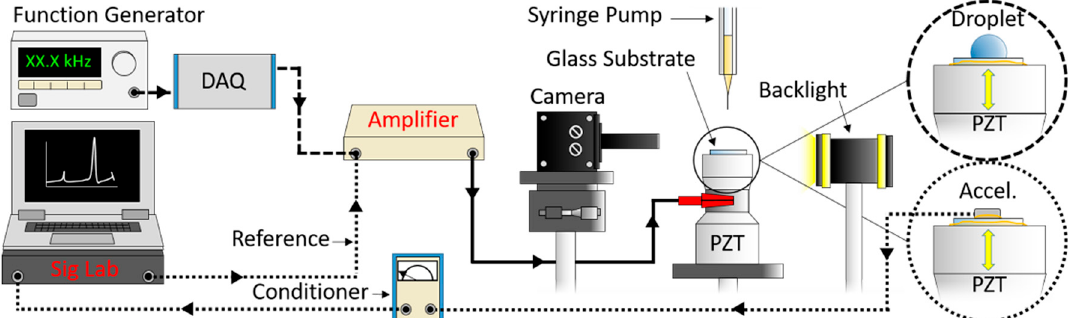
Figure 1. Droplets were vibrated via an ultrasonic transducer with a stepped sine wave signal of increasing amplitude (5 V/s) from zero to 300 V. Backlit images of vibrating droplets were recorded at 30 frames/s (dashed lines). Surface vibration was measured with an accelerometer by using a dynamic analyzer to compute the ratio of the cross-spectrum and the reference auto spectrum to obtain the frequency response (dotted lines).